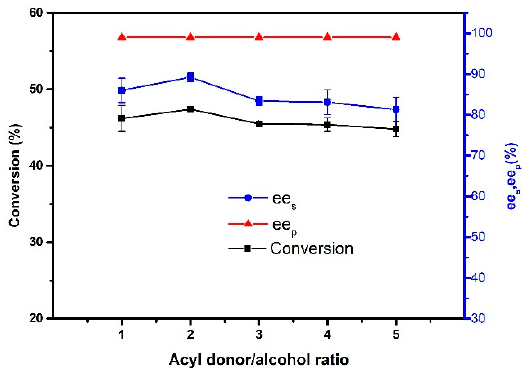
Figure 9. Effect of acyl donor/alcohol ratio on the resolution of 1-phenylethanol. Reactions performed with 5 mg magnetic CALB CLEAs and 2 mL of n-hexane containing 0.2 mmol of 1-phenylethanol at 50 °C for 48 h.